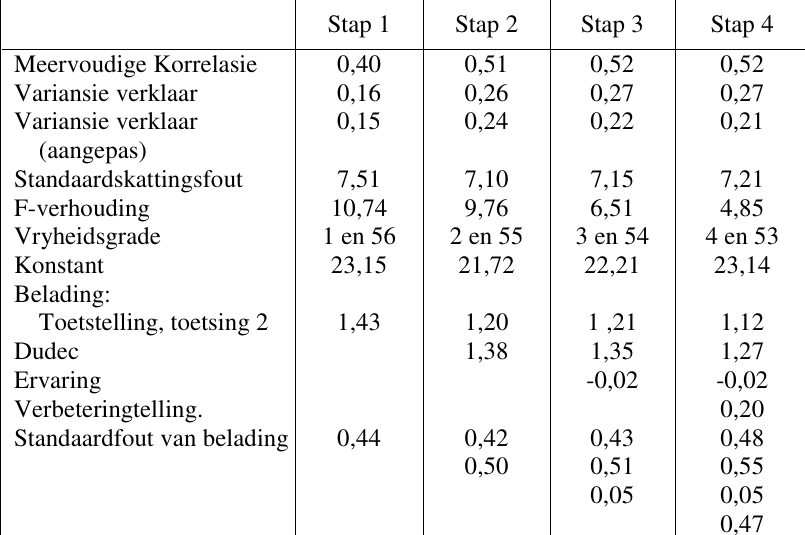
VOORSPELLINGSMODEL VAN DIE WERKVERRIGTING VAN ELEKTRISIËNHELPERS (16-ITEM